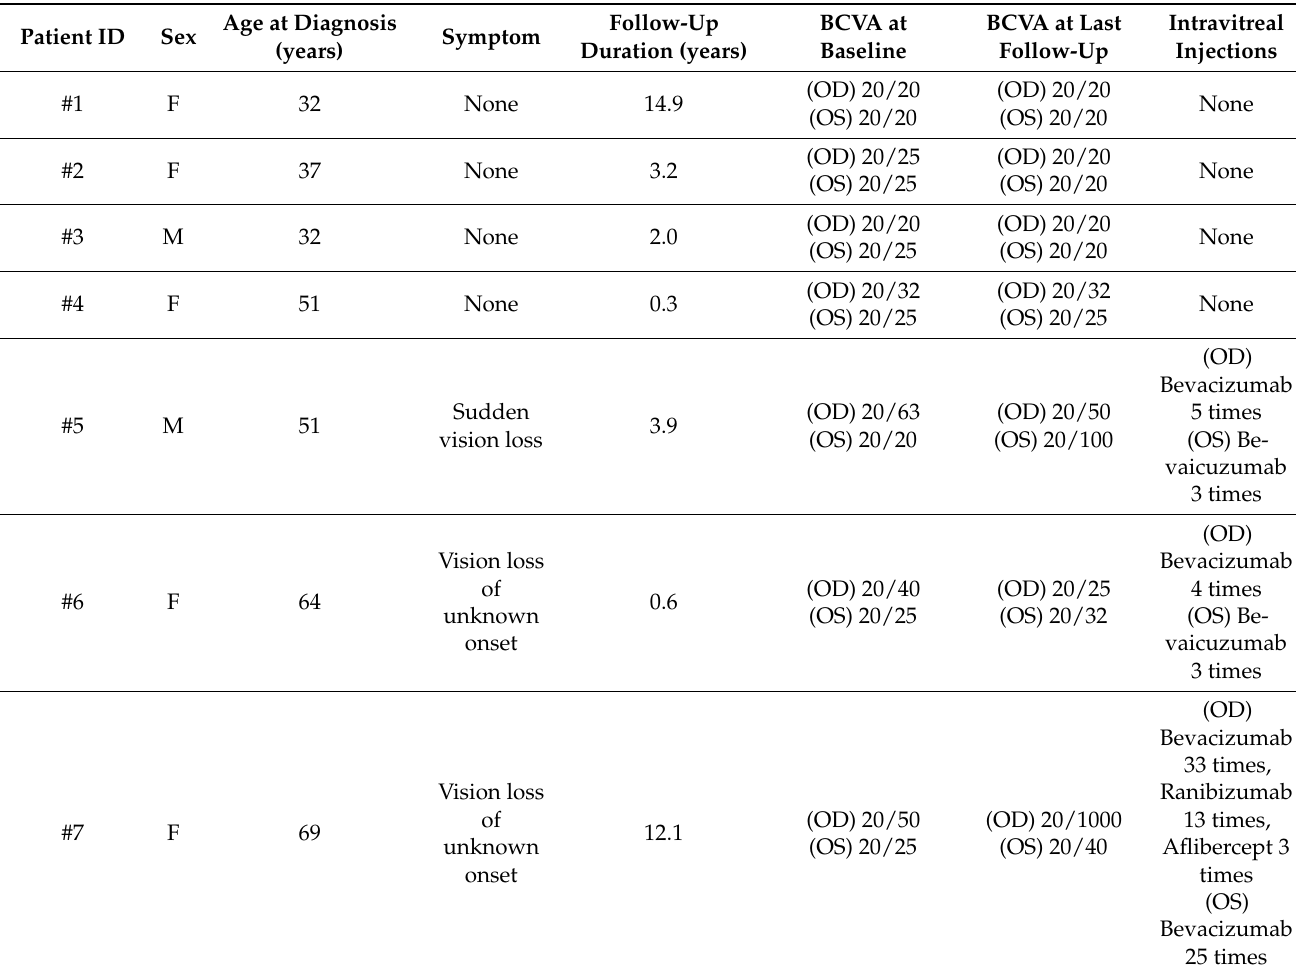
Table 1. Demographic and clinical features of